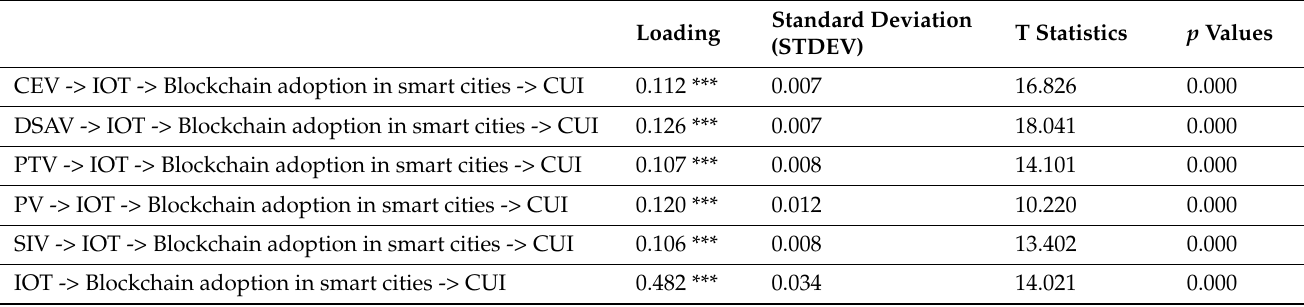
Table 6. Mediation Analysis